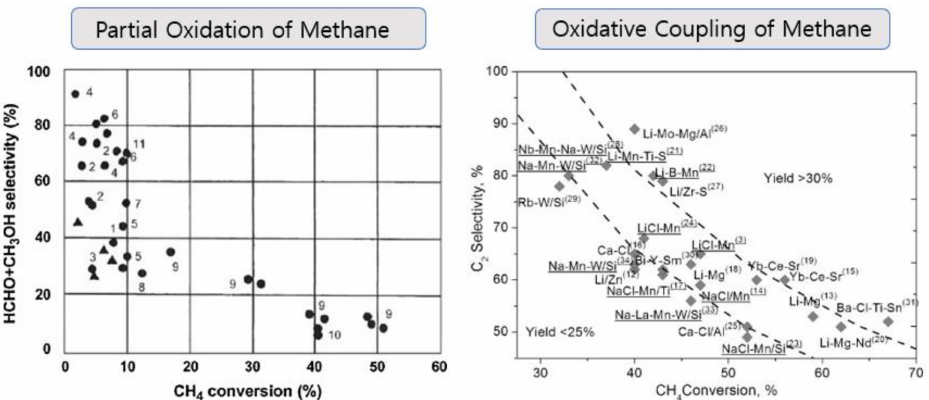
Figure 3. The relationship between product selectivity and methane conversion for partial oxidation of methane [16] and oxidative coupling of methane [17]. Copyright 2011, with permission from Elsevier. Copyright 2011, with permission from